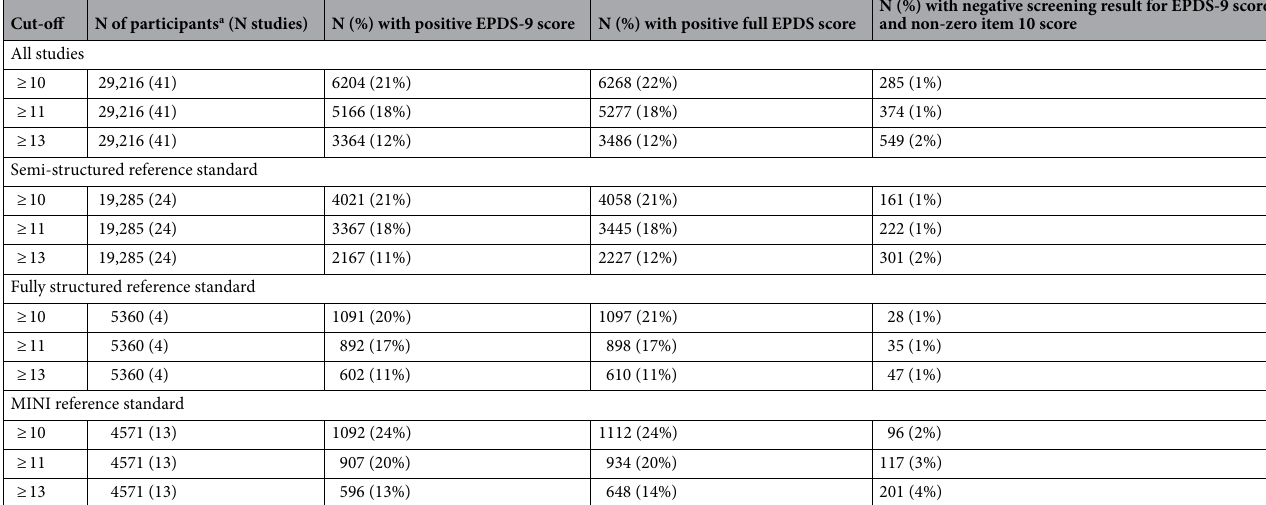
Table 2. Characteristics of participants who rated item 10 by EPDS-9 score at cut-offs ≥ 10, ≥ 11, and ≥ 13. EPDS, Edinburgh Postnatal Depression Scale. a Numbers of participants add up to > 10,906 as they were weighted by sampling